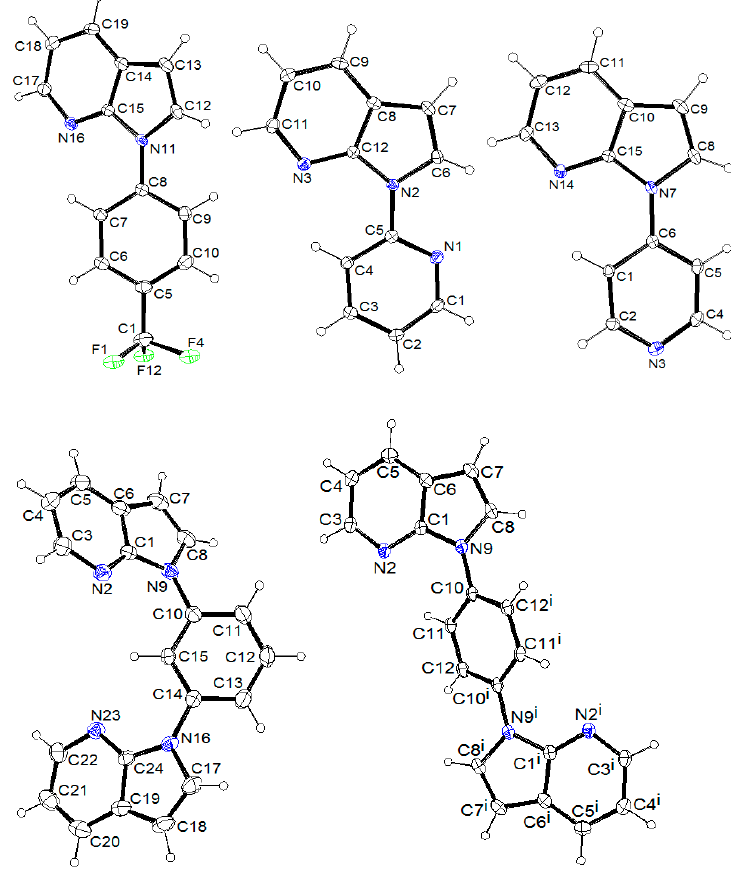
Figure 2. ORTEP diagrams (30% probability) of 1e , 1i , 1j , 2k and 2l . The X-ray diffraction data recorded for the compounds 1e and 1i deserve some additional comments. In the case of 1e , short intermolecular contacts were observed at the solid state between the pyridine nitrogen of azaindole and the hydrogen at C3 (2.644 Å), causing a linear chain, while a fluorine of the trifluoromethyl group is close to the hydrogens of two different azaindoles of another chain, one at C4 (2.651 Å) and the other at C6 (2.625 Å) (Figure 3A). In the case of 1i , the molecules are arranged in pairs of two parallel azaindoles (separated by about 3.3 Å); these pairs are connected by short contacts between the pyridine nitrogen of the azaindole of one pair and the hydrogen at C3 of the azaindole of another pair (2.609 Å) (Figure 3B). Overall, the XRD geometries are very close to those predicted by DFT calculations (see Supplementary Materials), including the most stable rotamer form.